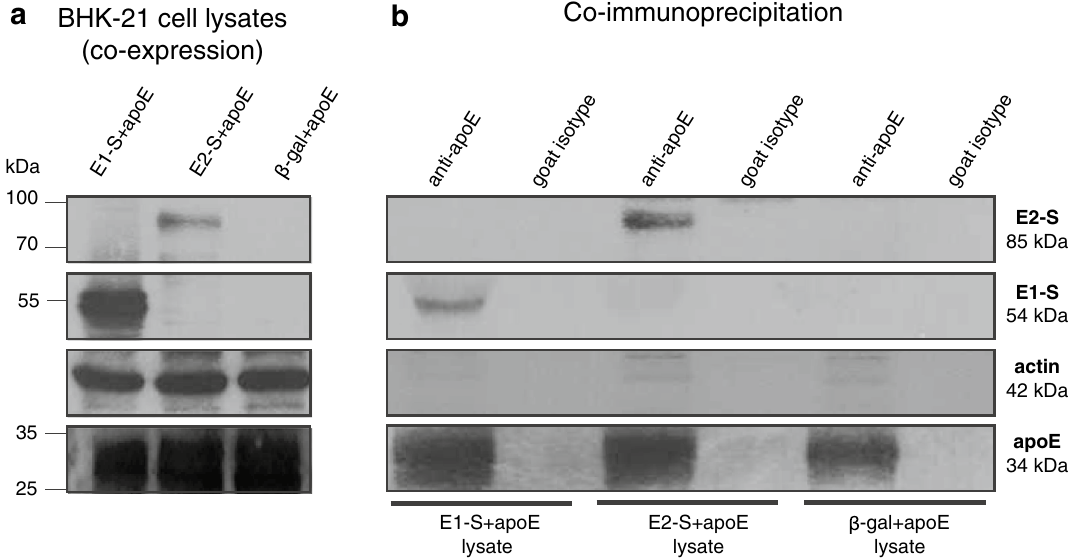
Figure 1. Evaluation of the interaction between apoE and HCV envelope glycoproteins fused to HBV S envelope protein (E1-S or E2-S) in co-immunoprecipitation assays. ( a ) Western-blot analysis of BHK-21 cell lysates co-expressing chimeric HBV–HCV E1-S or E2-S proteins, and apoE with the anti-E1 mAb (A4), anti-E2 mAb (H52), anti-apoE pAb (AB947) and anti-actin mAb (A1978). ( b ) Western-blot analysis of immune complexes from co-immunoprecipitation assays of BHK-21 cell lysates of interest with anti-apoE pAb (AB947) or with non-specific goat IgG (isotype control). Analyses were performed with the same antibodies as in panel ( a